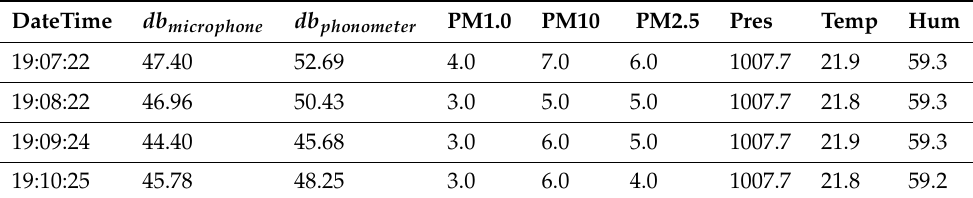
Table 6. Exemplary part of the third dataset.